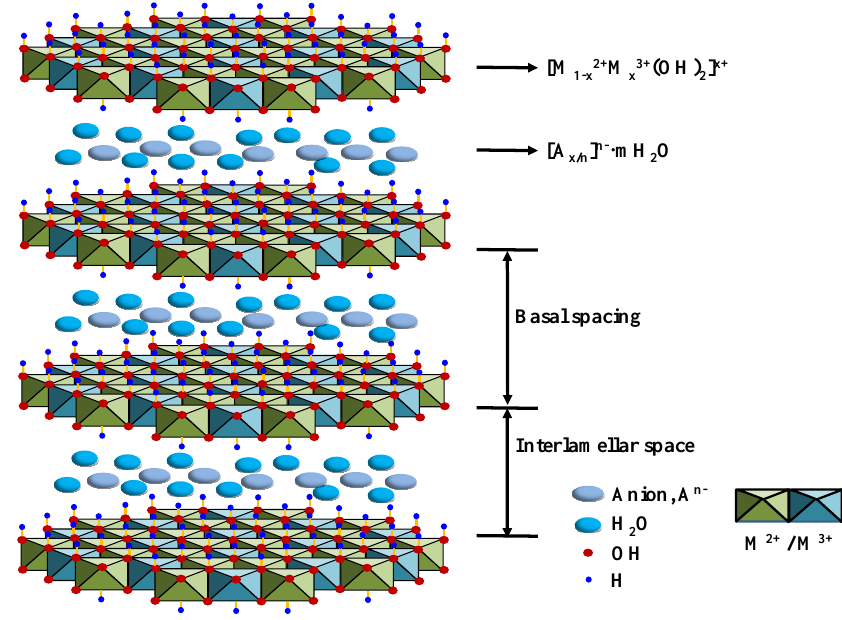
Figure 1. Structural representation of layered double hydroxides (LDH). Adapted from Ref. [4], Copyright 2017, MDPI.